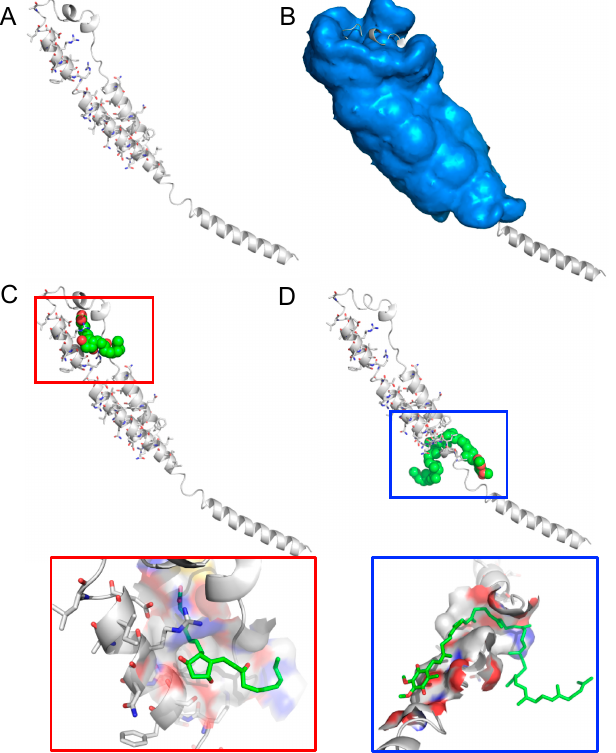
Figure 2. Binding modes of unoprostone and ubidecarenone to the membrane-fusion subunit from the Ebola virus envelope glycoprotein, GP2 (PDB identifier 1ebo, chain F). ( A ) Binding site residues (stick representation) predicted by COFACTOR by comparing binding motifs to a library of the PDB ligand-bound structures; ( B ) Search space for CANDOCK to dock fragments of small molecule compounds that are reconstructed while incorporating flexibility of both small molecule and the protein; ( C ) Docked conformation of uniprostone bound to the region of the fusion peptides forming disulfide-bonded loop that is homologous to an immunosuppressive sequence in retroviral glycoproteins. Uniprostone is shown as spheres (top) along with its interaction to the protein surface up to 10 Å (bottom); ( D ) Docked conformation of ubidecarenone bound to coiled coil region near the C-terminal end that acts as the membrane anchor. Ubidecarenone is shown as spheres (top) along with its interaction to the protein surface of the coiled coil region up to 10 Å (bottom). Together, these two molecules likely disrupt the conserved disulfide-bonded loop and the linker region that function as a hinge, transferring information from the GP1 receptor binding to trigger a conformational change in GP2, thereby disrupting the membrane fusion